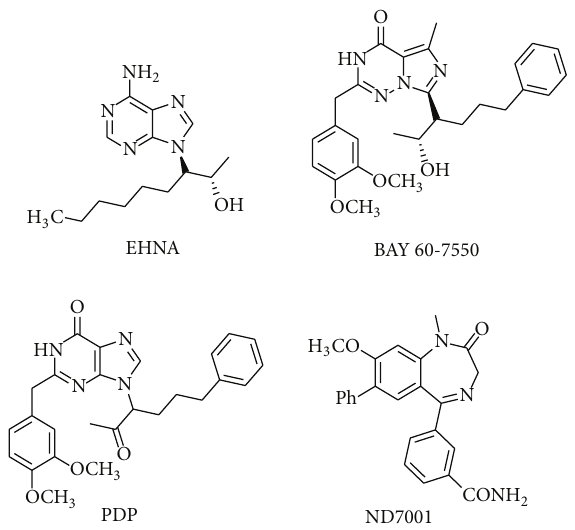
Figure 1: Structures of EHNA, BAY 60-7550, PDP, and ND7001.